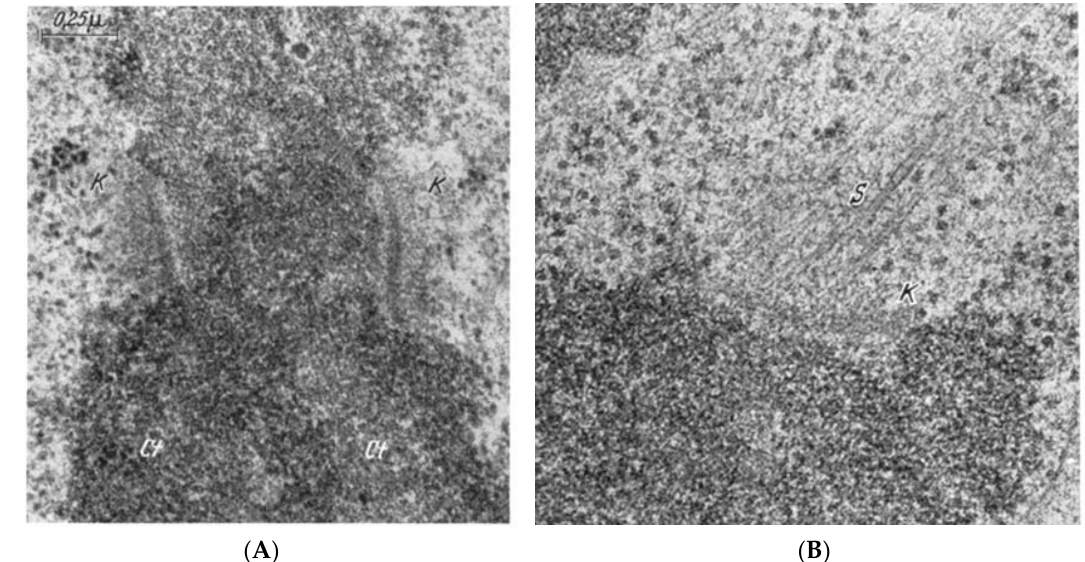
Figure 9. Kinetochores ( K ) are the specializations on mitotic chromosomes ( Ct ) that bind MTs. ( A ) = sister kinetochores in a mammalian cell, strain CHO, treated with colcemid to block MT formation; ( B ) = a kinetochore after removal of the drug and regrowth of spindle MTs ( S ). From Brinkley and Stubblefield, 1966 [33]. With permission from Elsevier Publishing.